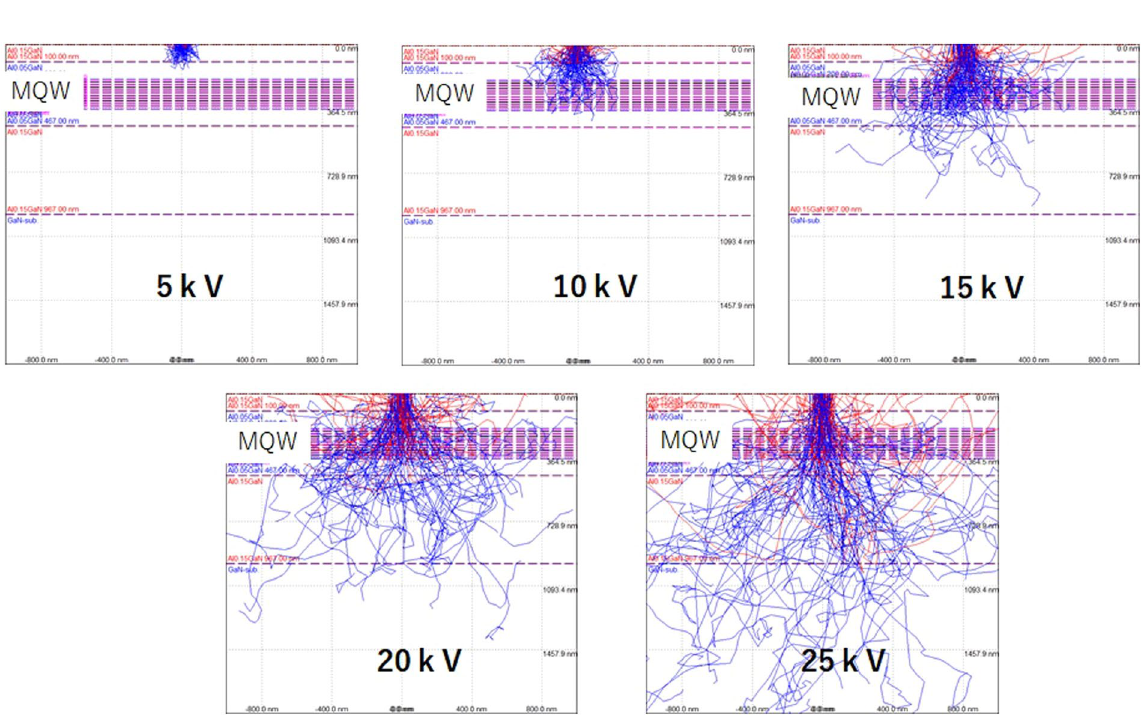
Figure 2. Trajectory of electron beam with accelerating